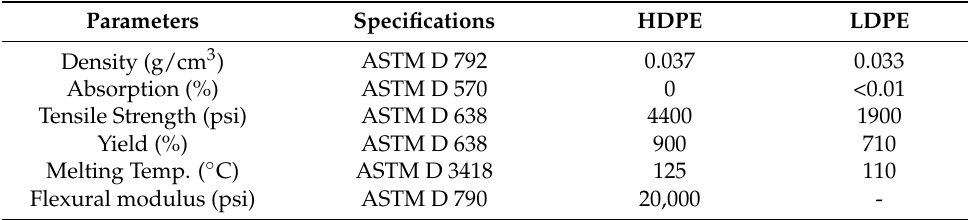
Table 2. The physical properties of polymers.